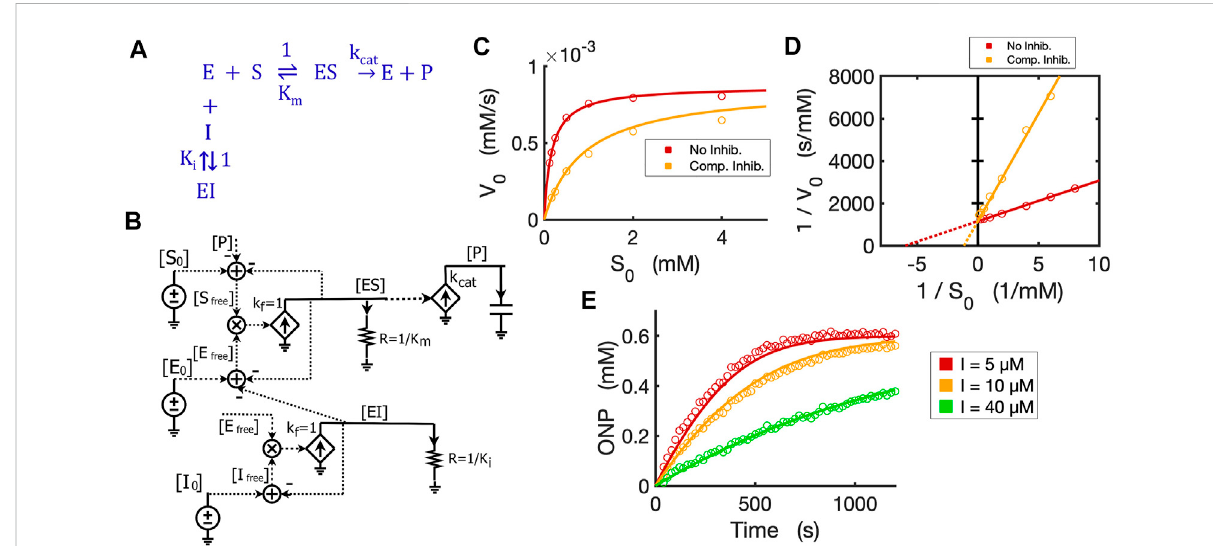
FIGURE 5 Circuit model of competitive inhibition. (A) The classic reaction scheme for competitive inhibition. (B) The circuit model for competitive inhibition. In this case, E is beta-galactosidase, S is ONPG, and the competitive inhibitor is phenylethyl beta-D-thiogalactopyranoside (PETG). (C) Simulation curves of initial reaction rate (V 0 ) versus initial substrate concentration [S 0 ] fi tted to experimental data in the absence and presence of PETG (10 µM) when E 0 = 0.3 nM. (D) Lineweaver-Burk plot showing linearized curves of 1/V 0 ~1/S 0 fi tted to experimental data with or without the inhibitor, which have the same Y -intercept, 1/V max . (E) The model curves of product dynamics over time with varying inhibitor concentrations fi